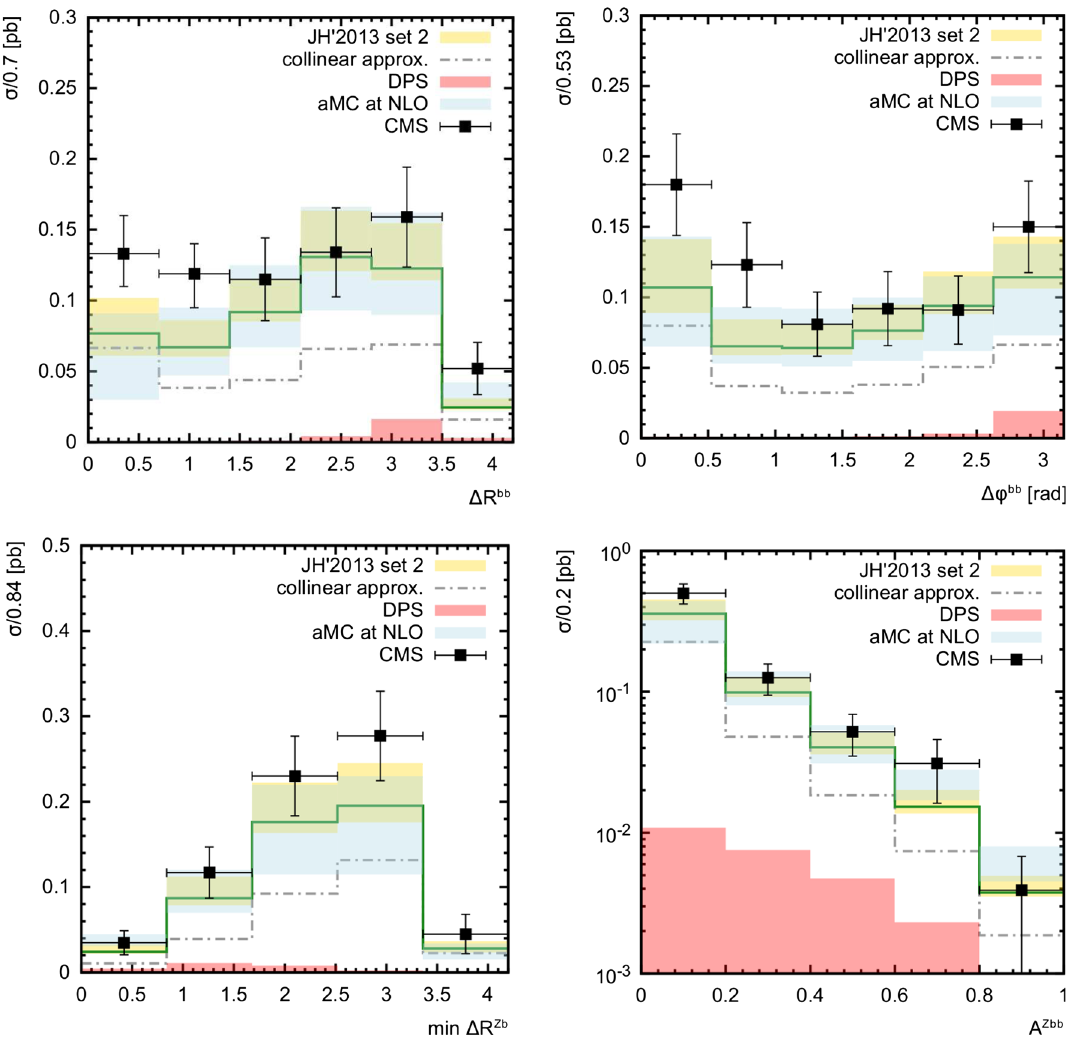
√ s = 7 TeV. Notation of the histograms is the same as in Fig. 1. The data are